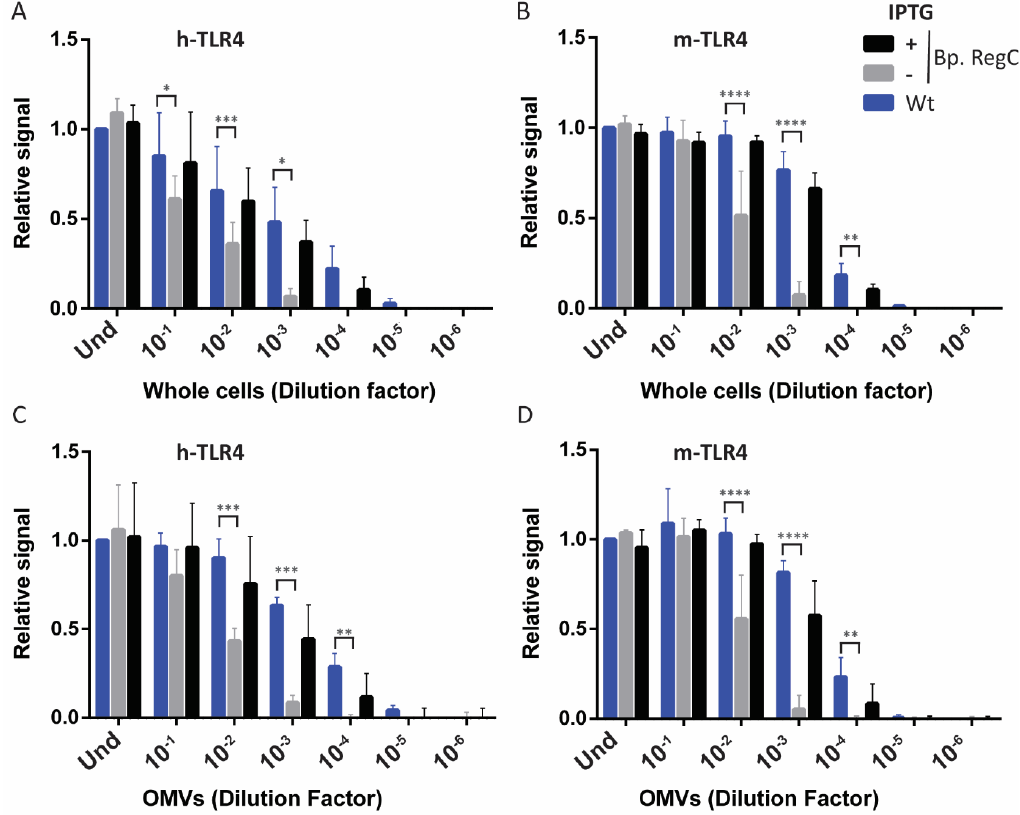
Figure 5. TLR4 activation by whole-cell and OMV preparations. HEK-Blue cells expressing either h-TLR4 ( A , C ) or m-TLR4 ( B , D ) were incubated for 17 h with 10-fold serial dilutions of heat-inactivated whole cells (the OD 600 of the undiluted cell suspensions (Und) was 0.15) ( A , B ) or isolated OMVs (the protein concentration in the undiluted preparations (Und) was 1 µg/mL) ( C , D ). Diagrams show means and standard deviations of relative SEAP activity calculated as the ratio between the signal measured for each dilution of each strain and the signal measured for Und. Wt (parental strain). Three independent experiments were performed in duplicate (whole cells) or singularly (OMVs). Statistical comparisons showed significant differences relative to the wild type for Bp. RegC grown in absence of IPTG but not for Bp. RegC grown with IPTG. Dilutions with statistically different results are indicated with asterisks (*, p ≤ 0.05; **, p ≤ 0.01; ***, p ≤ 0.001; ****, p ≤ 0.0001).